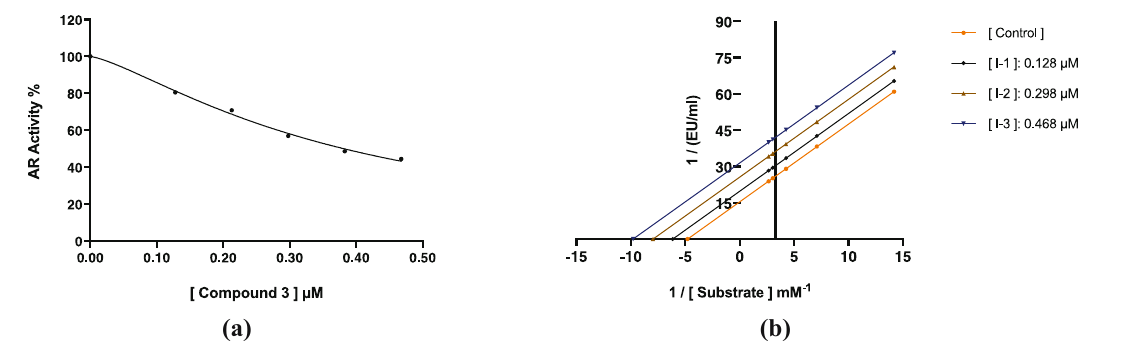
Figure 2: ( a ) Percentage activity versus inhibitor concentration graph of compound 3 at fi ve di ff erent concentrations. ( b ) Lineweaver – Burk plot of compound 3 .